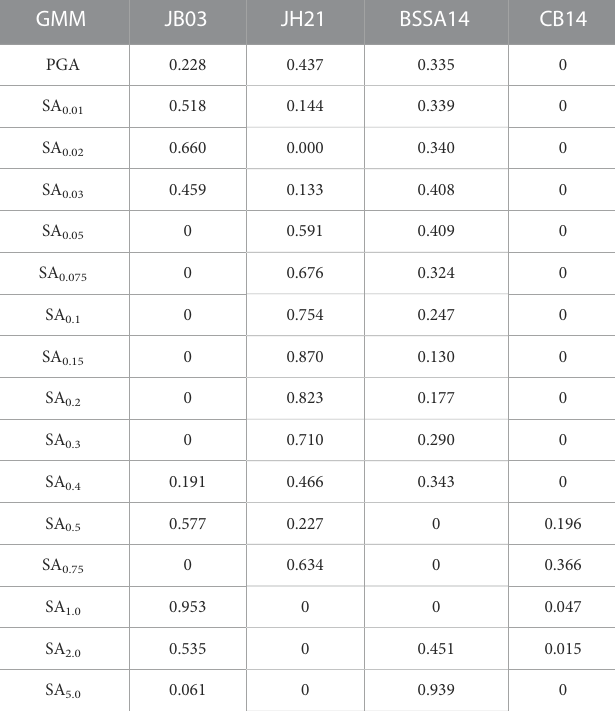
TABLE 6 Suggested GMMs and weights minimizing σ tt per IM for large M W ( >